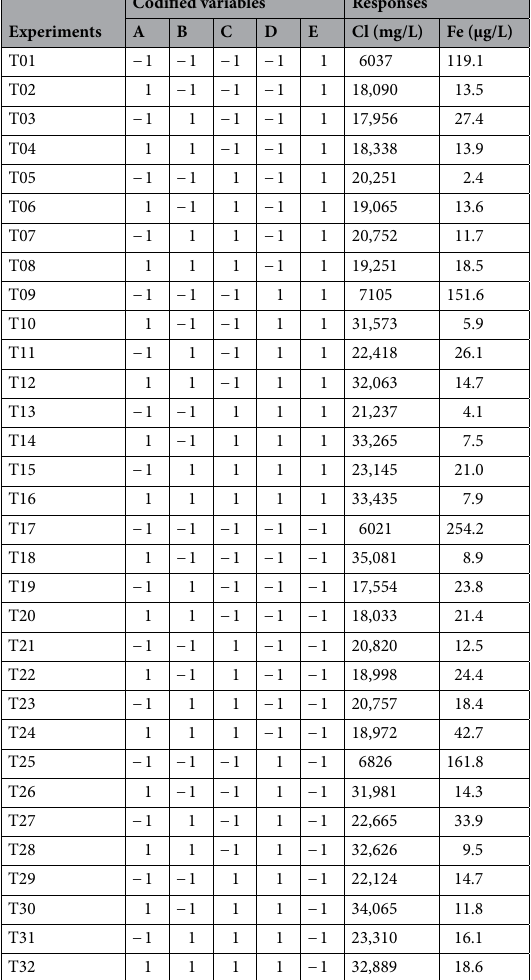
Table 3. Design matrix and results of the 2 5 full factorial screening